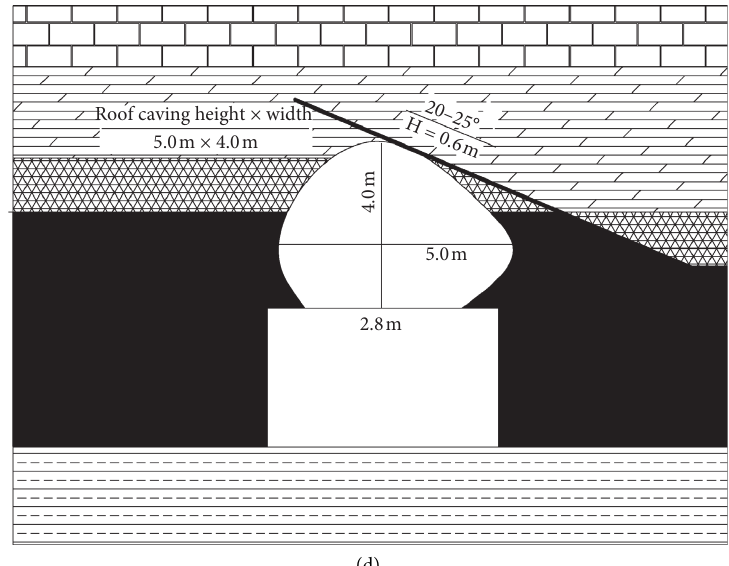
Figure 1: Types of disasters due to the caving of the roof of a roadway: (a) examples of caving caused by local block falling between anchor bolts (cables) and a cross-sectional block falling; (b) examples of roof caving induced by an inferior combination of strata of composite layered roofs; (c) examples of caving in a butterfly-shaped plastic zone; (d) an example of caving accident of a loose and fractured roof owing to improper support for small implicit faults.